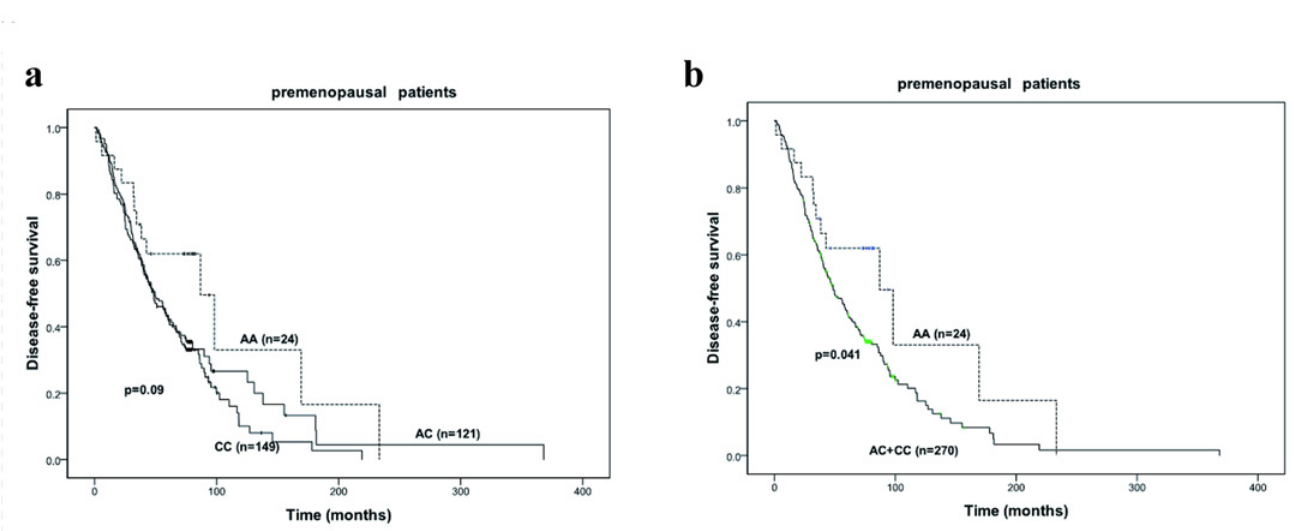
Fig 2. Survival curves for the premenopausal patients. a. Disease-free survival of the premenopausal women stratified by CYP19 rs4646 genotypes (CC vs AC vs AA). b. Disease-free survival of the premenopausal women grouped according to CYP19 rs4646 genotypes (AA vs AC + CC).